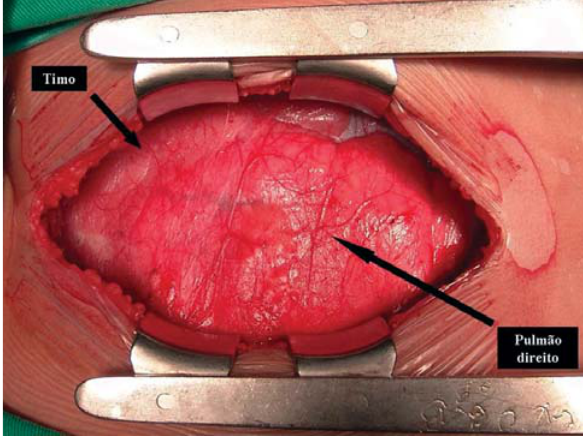
Fig. 3 – Mediastino anterior ocupado pelo pulmão direito